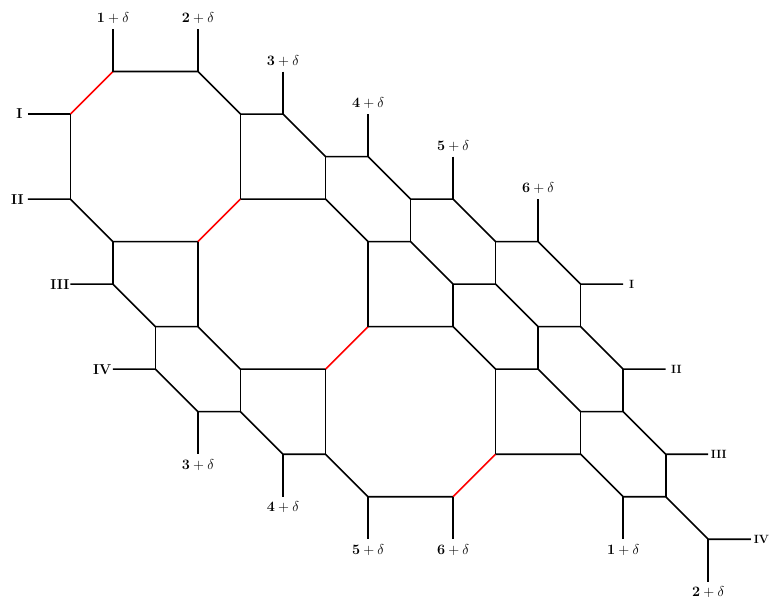
Figure 22 . Cutting and re-gluing of the web diagram in (cid:12)gure 21.